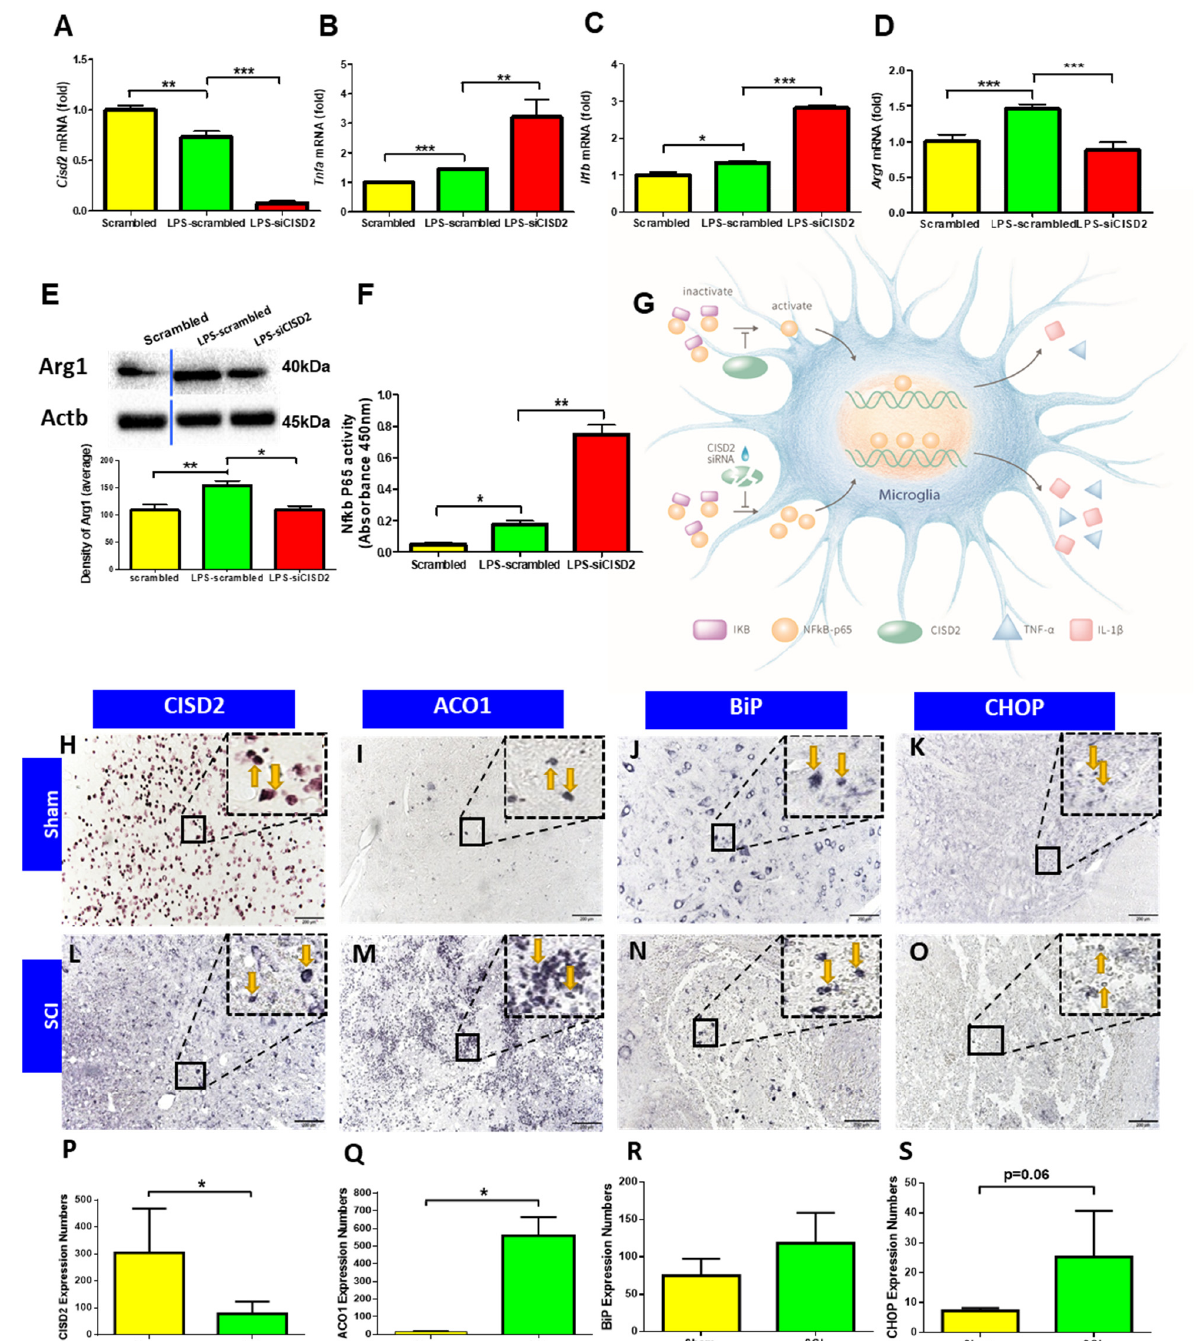
Figure 5. siCISD2-mediated Cisd2 knockdown exacerbated the inflammatory response, promoted proinflammatory M1 phenotype, and enhanced NF- κ B p65 nuclear translocation in EOC microglial cells. ( A ) At 8 h post-lipopolysaccharide (LPS) treatment, Cisd2 mRNA expression was decreased in the LPS-stimulated EOC microglial cells. The mRNA expression levels of Tnfa ( B ) and Il1b ( C ) were higher and the mRNA ( D ) and protein expression ( E ) levels of Arg1 (M2 microglial cell marker) were lower in the siCISD2-transfected LPS-stimulated microglial cells than in the scrambled RNA-transfected LPS-stimulated microglial cells. The upper panel in ( E ) indicates a representative immunoblot of the protein expression of Arg1 (40 kDa). Actb (45 kDa) was used as an internal control. ( F ) The results of the enzyme-linked immunosorbent assay (ELISA) revealed that LPS en- hanced the DNA-binding activity of NF- κ B p65 subunit upon Cisd2 knockdown. Vertical bars in- dicate mean ± standard error of mean of mRNA ( n = 3 for each group), protein ( n = 3 for each